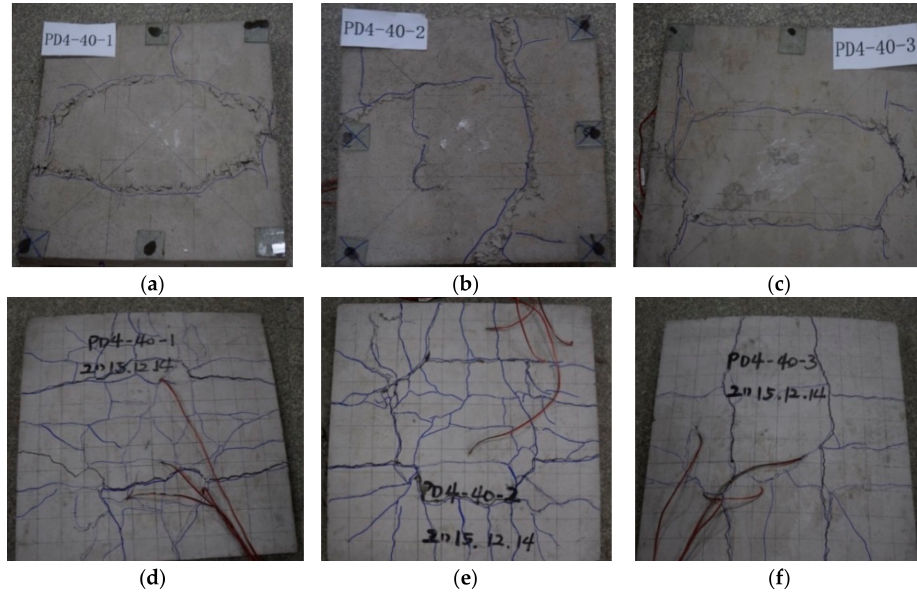
Figure 7. Failure modes of ordinary concrete wallboard. ( a ) PD4-40-1 (top surface); ( b ) PD4-40-2 (top surface); ( c ) PD4-40-3 (top surface); ( d ) PD4-40-1 (bottom surface); ( e ) PD4-40-2(bottom surface); ( f ) PD4-40-3 (bottom